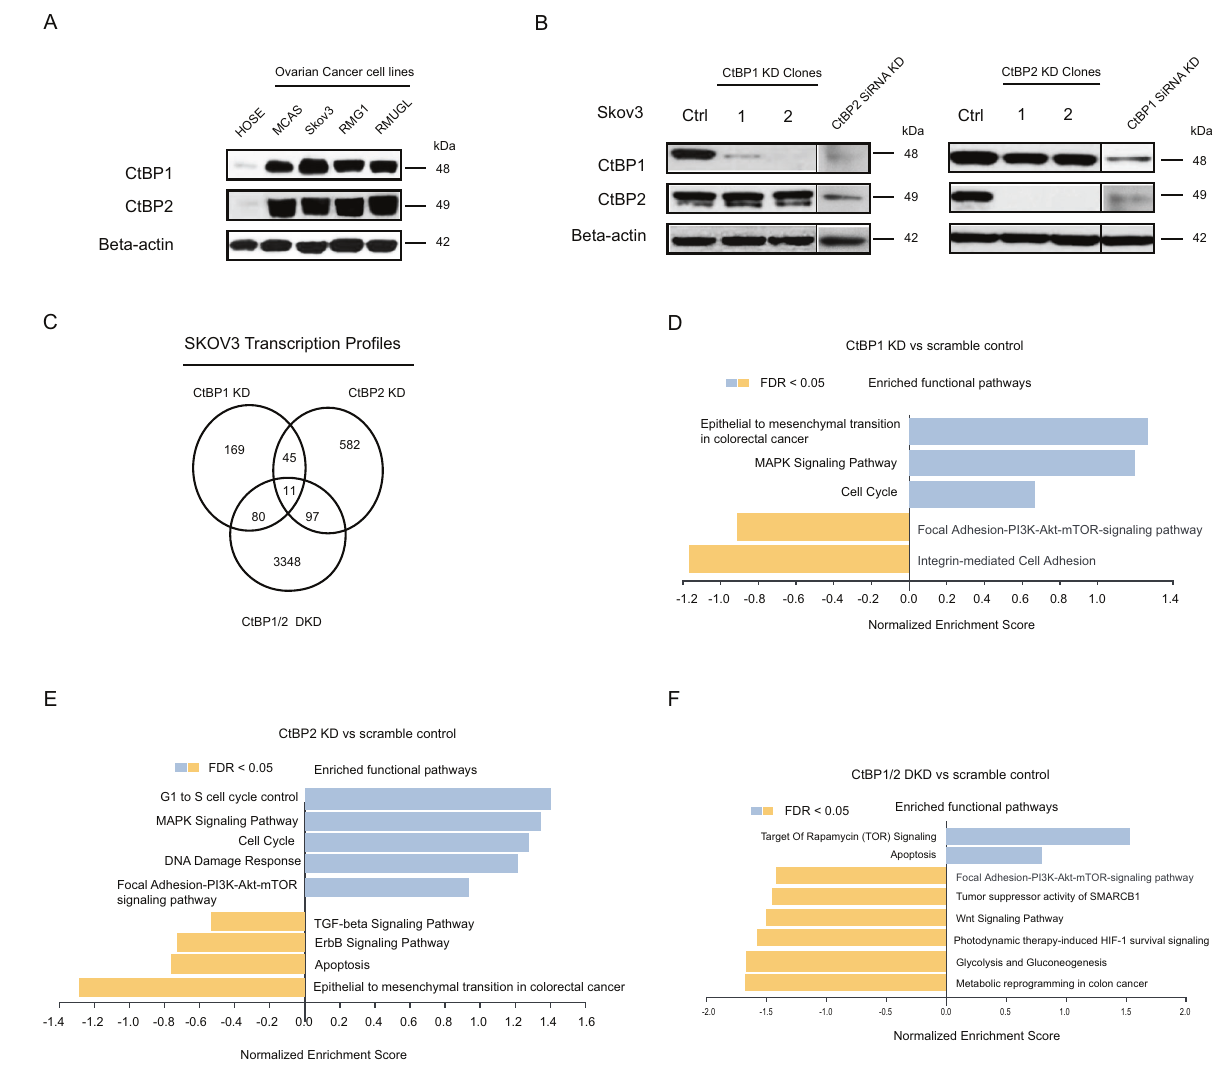
Fig. 1 CtBP1/2 overexpressed in ovarian cancer cell lines and stable knockdown cells transcription pro fi ling analysis. The overexpression of CtBP1/2 was analyzed by western blot in ovarian cancer cell lines ( A ). CtBP1/2 stable knockdown in SKOV3 cells generated by lentivirus containing CtBP1/2-targeting shRNA constructs and siRNA transient double knockdown (KD) ( B ). The Venn diagram showed the overlapped signi fi cant changed genes among CtBP1KD, CtBP2 KD, and CtBP1/2 double KD ( C ). The enriched functional pathways were summarized in CtBP1KD vs. control ( D ), CtBP2 KD vs. control ( E ), and CtBP1/2 double KD vs. control ( F knockdown serous ovarian cancer cells utilizing transcription pro fi le enrichment analysis. CtBP proteins had been studied for their role in genomic stability and DNA repair. RESULTS Established CtBP1/2 stable knockdown in serous ovarian cancer cells CtBP1/2 was found to be abnormally overexpressed in several ovarian cancer cell lines, including MCAS, SKOV3, RMG1, and RMUGL (Fig. 1A), and a very weak signal was found in human normal ovarian epithelium (HOSE). It is thought that CtBP1/2 overexpression contributes to the abnormality of ovarian cancer cells. The lentivirus shRNA constructs successfully generated scramble control and CtBP1/2 knockdown (CtBP1 KD, CtBP2 KD) SKOV3 cells. To avoid off-target effects, each target gene was initially screened with fi ve different shRNA constructs, and then selected two independent clones for the next step functional assay, which were validated by Western blot with clearly CtBP